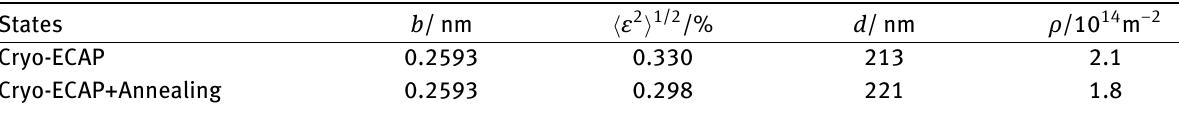
Figure 1: TEM images of the Cu-7%Al alloy before (a) and (b) and after annealing (c) and (d). Table 1: Dislocation density and effective grain size of Cu–7%Al alloys after Cryo-ECAP and